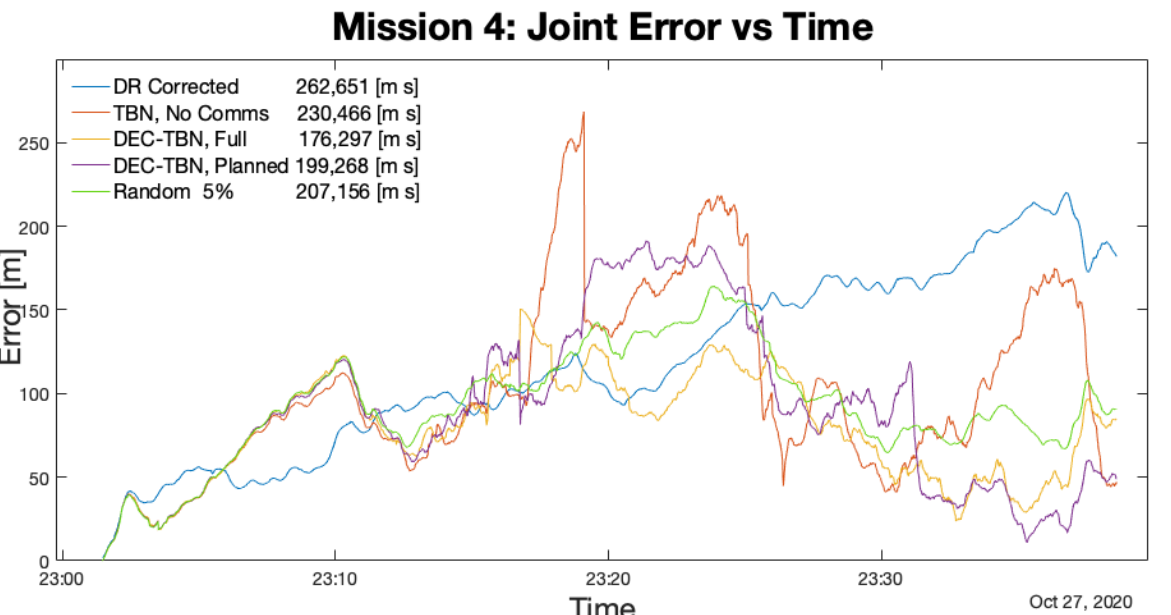
Figure 15. Joint Error for Mission 4. The spikes in TBN result from poor altimeter data for this mission. Dec-TBN full was able to compensate for the poor data better than dec-TBN planned. A low bandwidth random policy also happened upon a good set of communications for the